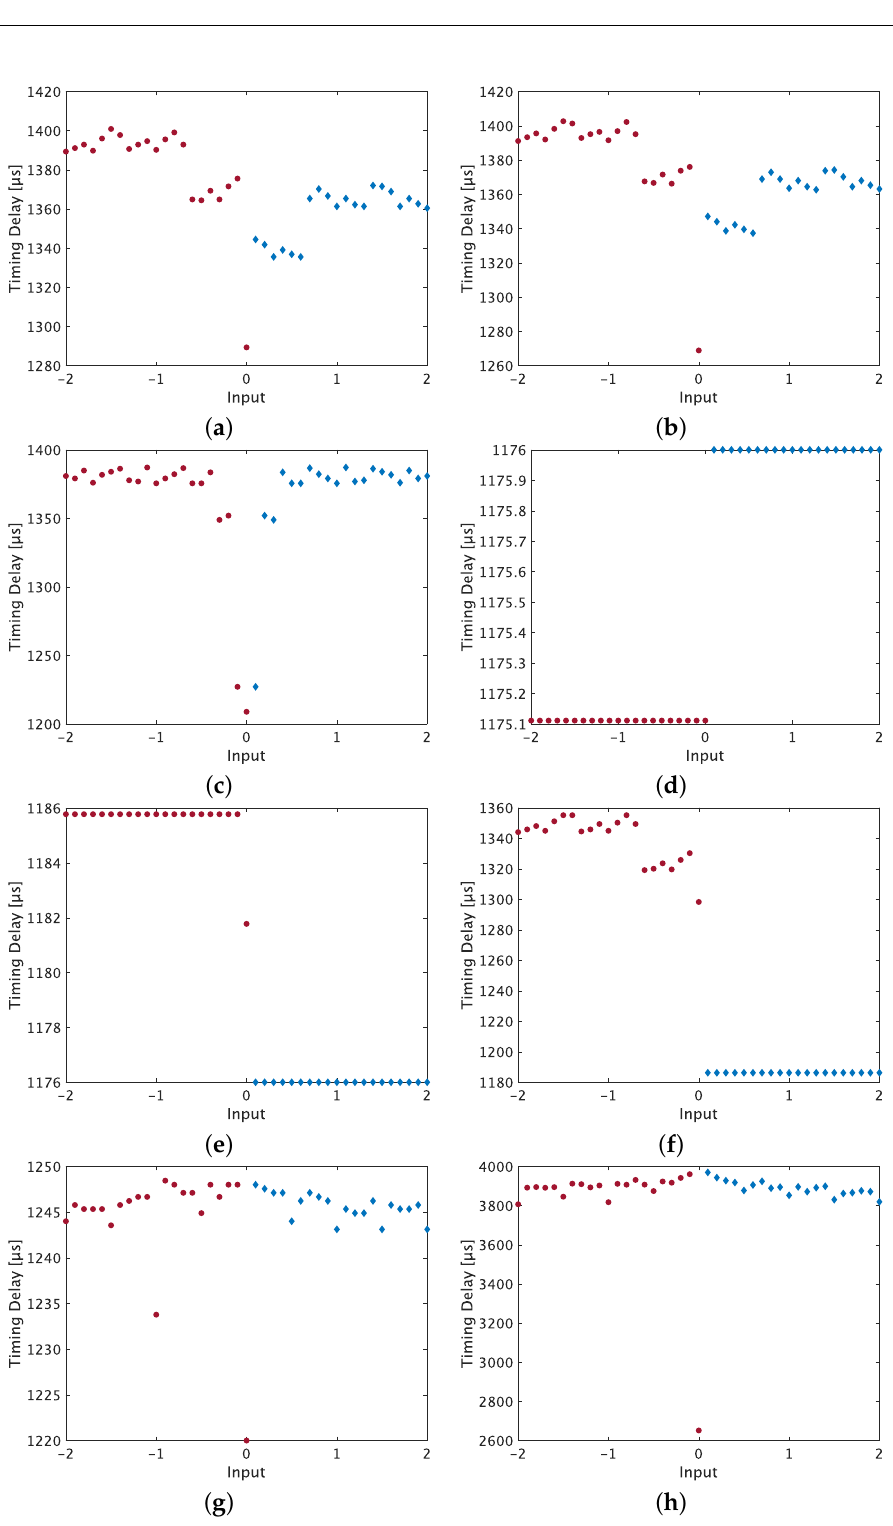
Figure 2. Timing Behavior of Similar Activation Functions. ( a ) Timing Behavior for Sigmoid. ( b ) Tim- ing Behavior for Swish. ( c ) Timing Behavior for Tanh. ( d ) Timing Behavior for ReLU. ( e ) Timing Behavior for Leaky ReLU. ( f ) Timing Behavior for SELU. ( g ) Timing Behavior for Fast Sigmoid when n = 1. ( h ) Timing Behavior for Fast Sigmoid When n =